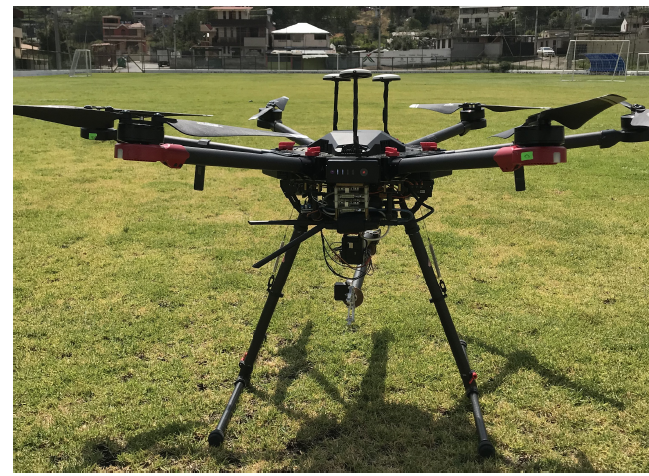
Figure 9. Hexacopter platform used in a real-world experiment.